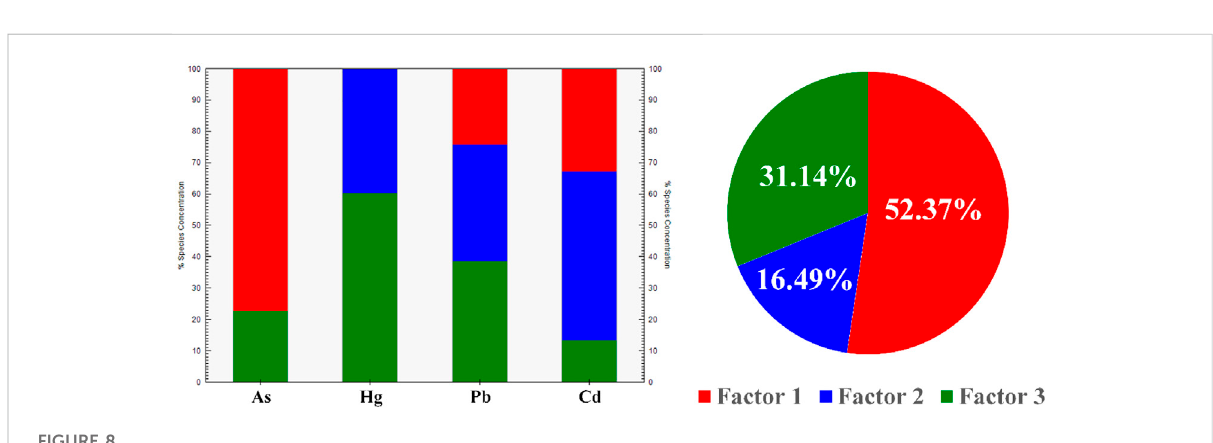
FIGURE 8 Identi fi cation of major sources of heavy metal pollution in